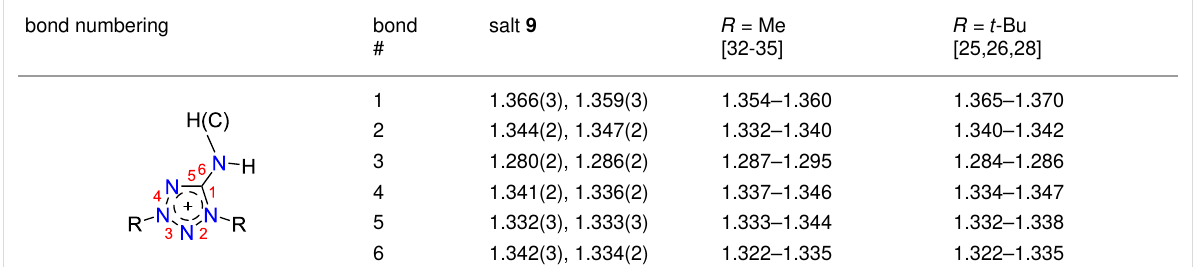
Table 3: The bond lengths of the tetrazole ring and exocyclic C–N bonds (Å) in salt 9 and the corresponding literature data for 1,3-di-alkyltetrazolium- 5-aminide salts a,b . bond